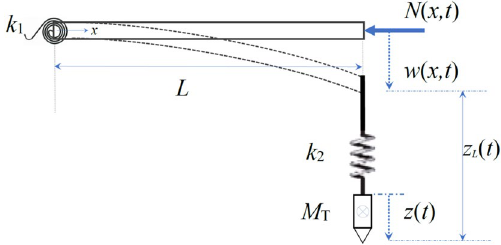
Fig. 2 Deflection of the beam with constant axial load and spring- mass attached at free end x = L (Fig. 1). The lateral linear spring stiffness